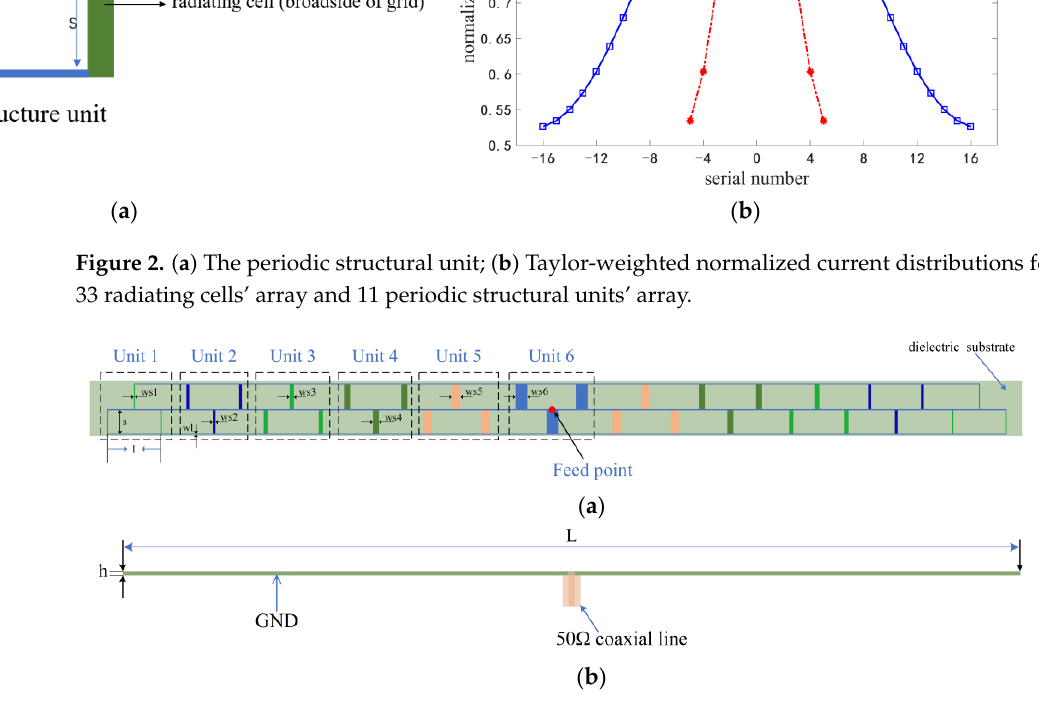
Figure 3. ( a ) Structure of the microstrip grid antenna; ( b ) the feeding structure.